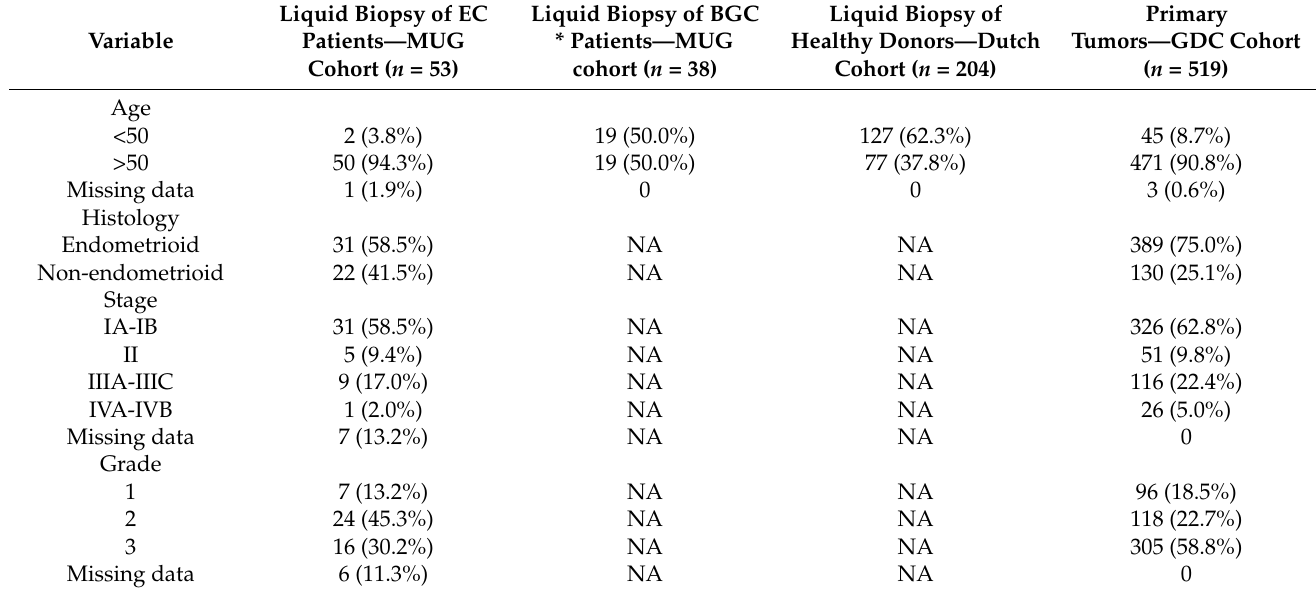
Table 1. Clinicopathologic data of the study subjects: liquid biopsy of patients with EC, liquid biopsy of patients with benign gynecologic conditions (BGC, MUG cohort), liquid biopsy of healthy controls and EC primary tumors (GDC cohort). * BGC, benign gynecologic conditions, NA–not